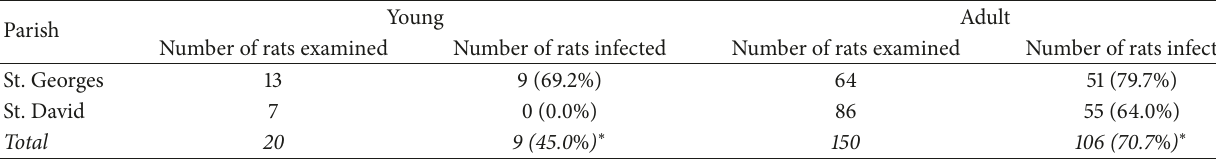
Table 3: Prevalence of Cysticercus fasciolaris in brown rats of Grenada according to age.